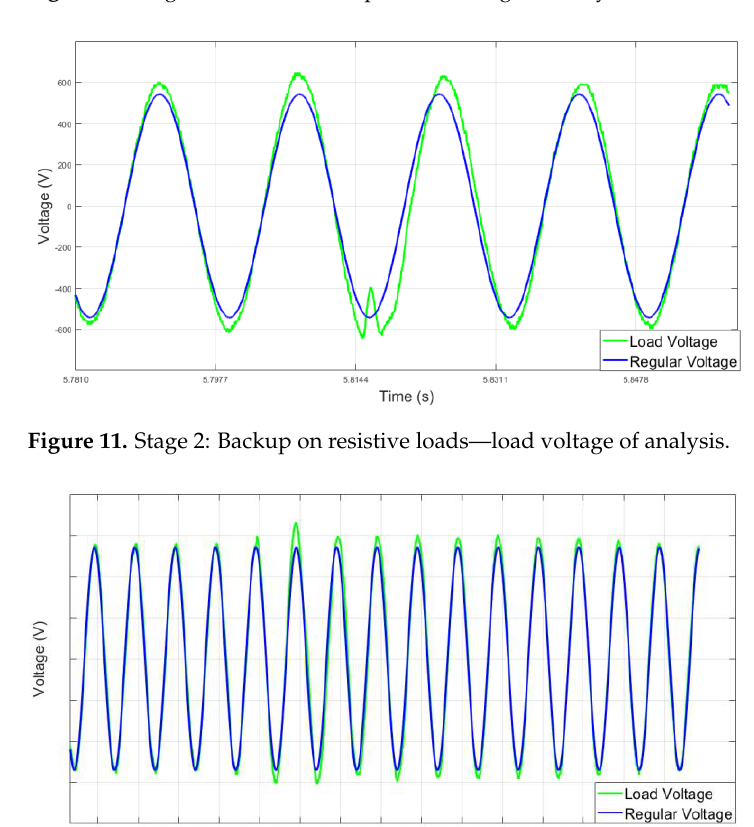
Figure 13. Stage 4: Backup on capacitive loads — load voltage of analysis. From the tests, it was possible to verify that the PCS-STS performs the physical disconnection between the load and the electrical grid, and switching to stand-alone mode occurred in milliseconds. This quickness is essential for the backup to be effective in protecting against the shutdown of critical loads. It was also possible to evaluate the ability of the BESS to operate as grid-forming (VF control), keeping critical loads with voltage magnitude and frequency at their rated values. 4.2. Real Case Study In the following sections, two real cases of the BESS acting in the supply of microgrid loads are presented during the disturbances of deviations in the magnitude and frequency of the voltage of the local electrical grid, which occurred in an unforced way.